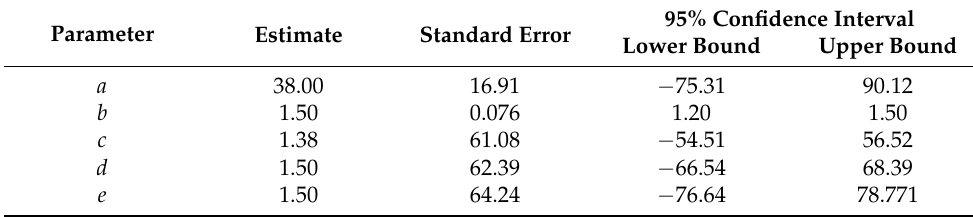
Table 7. ANOVA table with RH higher than 70%. Source Sum of Squares df Mean Squares Regression 39,529.737 8 4941.217 Residual 903.623 561 1.611 Uncorrected total 40,433.361 569 - Corrected total 33,013.163 568